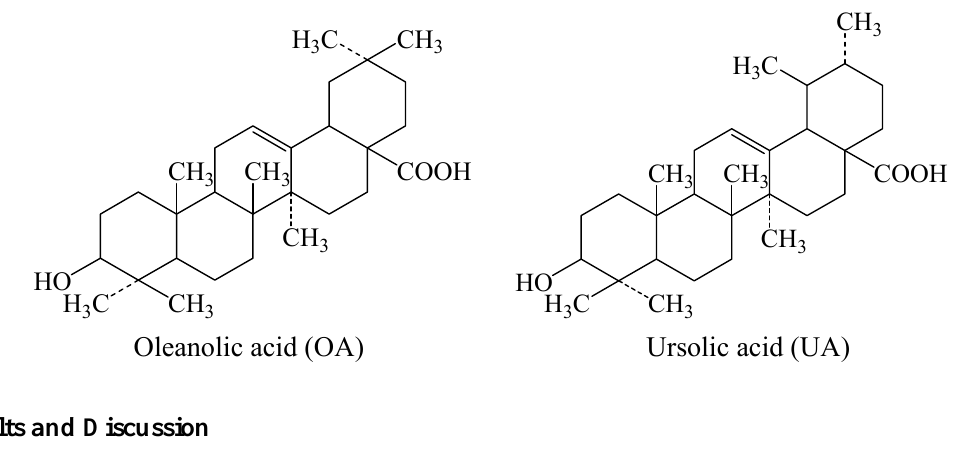
Figure 1. Chemical structures of OA and UA.